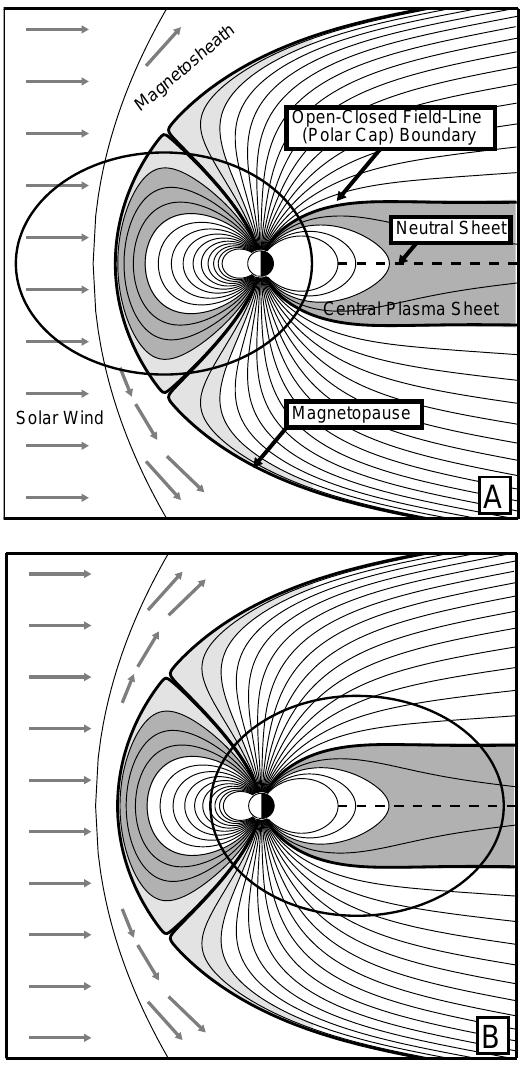
Fig. 2. (a) The orbit of Cluster was selected to maximize the op- portunities to study cusp, magnetosheath, and bow shock processes during periods of dayside apogee. (b) Nightside apogee takes Clus- ter through the CPS in the mid-tail reconnection region, ideally suited for studies of substorms, and thin current sheets.